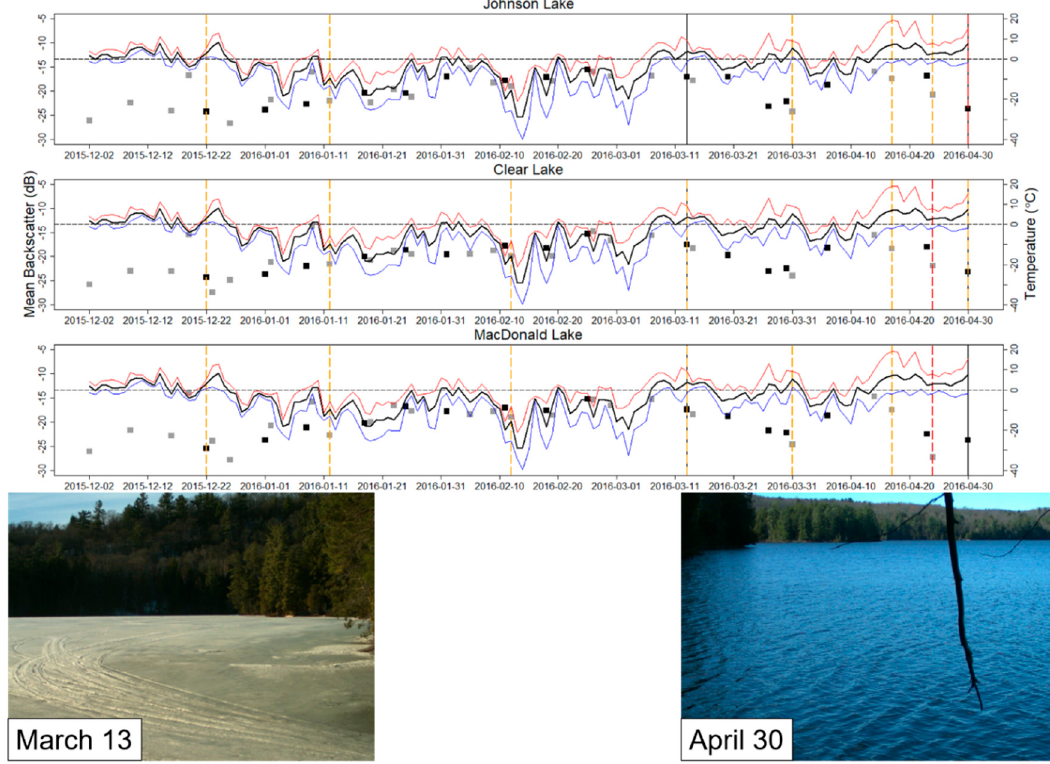
Figure 9. Backscatter and temperature evolution for the 2015/2016 ice season. Black squares represent images that were acquired in the PM and grey squares representing images acquired in the AM. The orange lines indicate when a major melt event was determined. The red lines indicate WCI and the solid lines are the dates of the sample images. The two images are from the lake ice monitoring network and display the surface conditions corresponding to the respective event. The 13 March image was acquired from MacDonald Lake and the 30 April image was acquired from Johnson Lake.